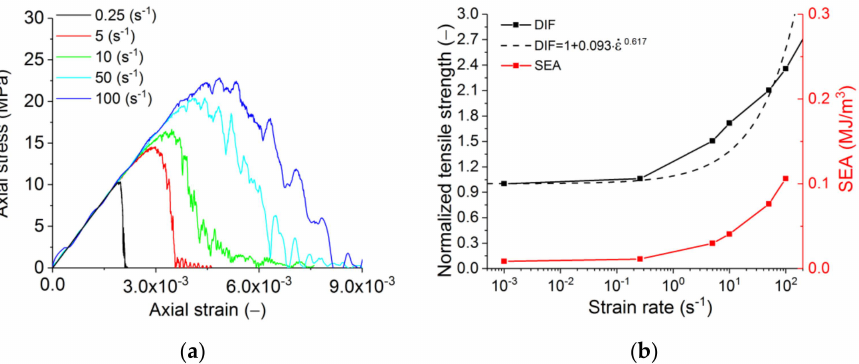
Figure 12. Results for dynamic tensile loading: ( a ) stress–strain diagrams, ( b ) effect of the strain rate on normalised strength and specific energy absorption (SEA). The dashed line is the analytical approximation reported elsewhere